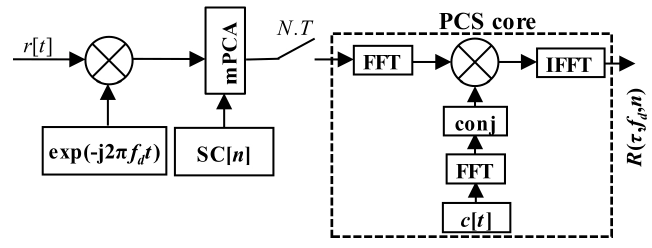
Figure 9. PCS and mPCA pre-correlation processing of SC .